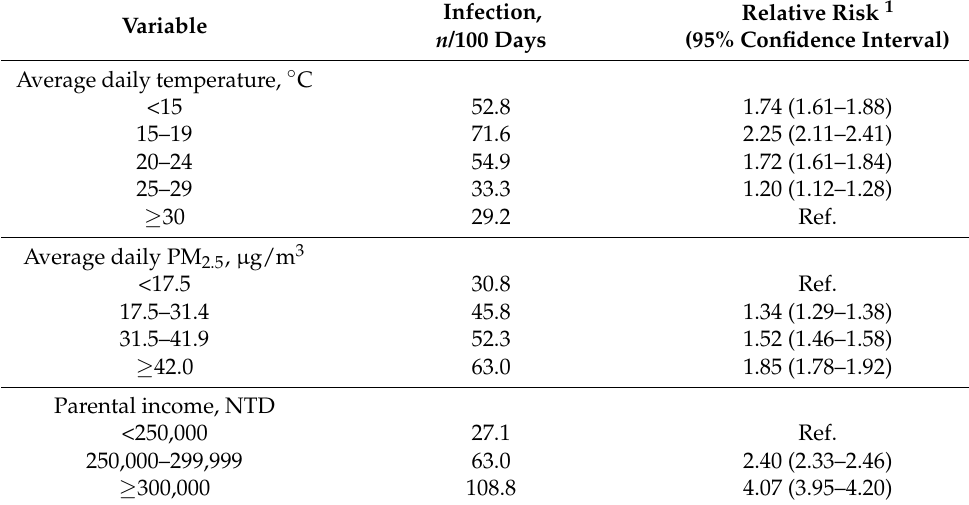
Table 1. Multivariable Poisson regression analysis estimated adjusted relative risk of rotavirus infection by temperature, PM 2.5 , and parental annual income.